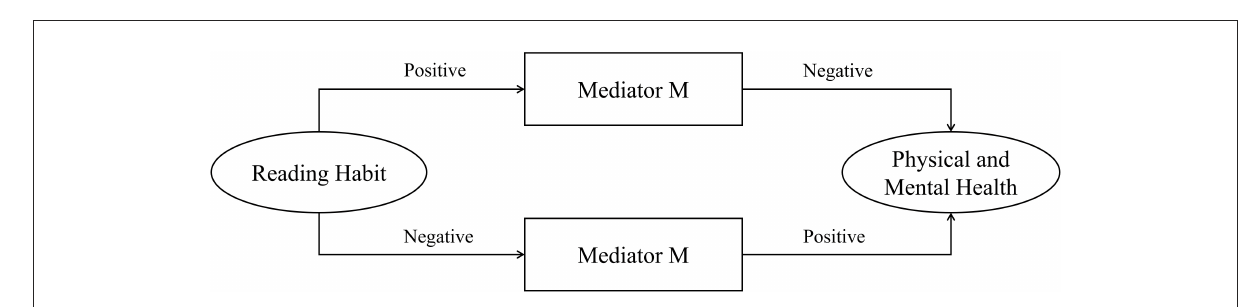
FIGURE3 Negative conduction path schema of mediator variable M.